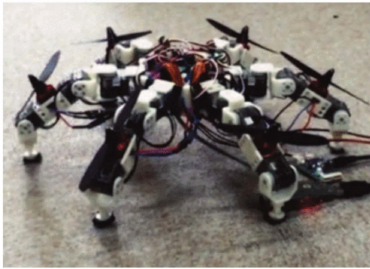
Figure 38. Hybrid robot prototype capable of walking and flying for steel bridge inspections [128].